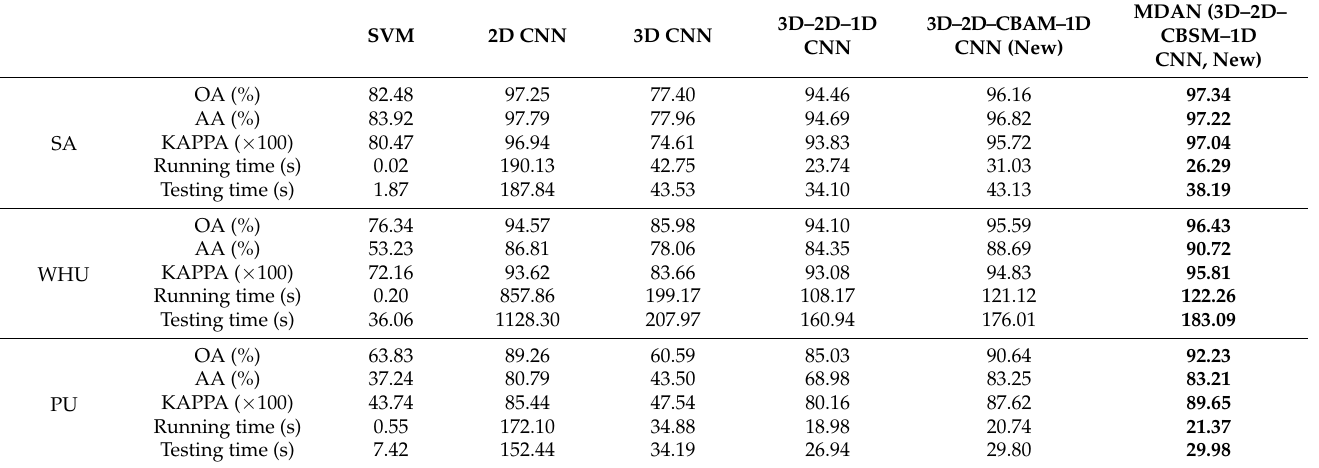
Table 5. Classification accuracies and efficiencies of the proposed two models and selected methods using the WHU, SA, and PU datasets, respectively, and the best performances are highlighted in bold.